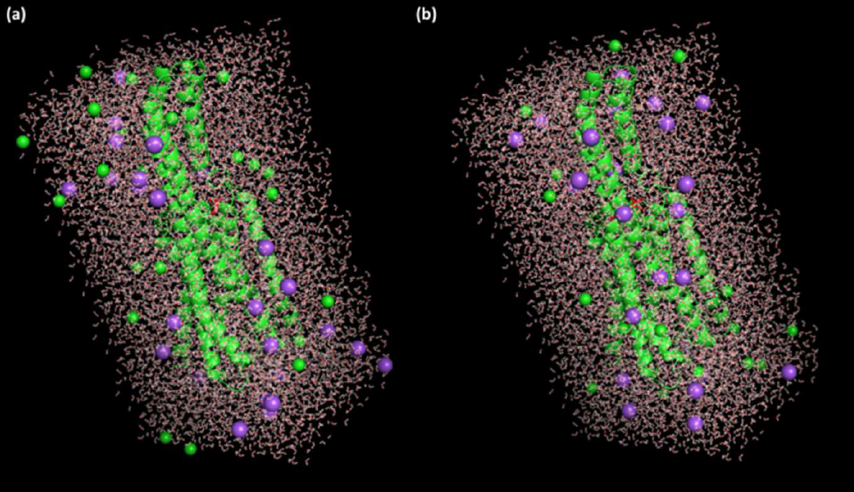
Figure 1. Receptor–ligand complex ( a ) (Bar)–Serotonin and ( b ) (Bar–CLA)–serotonin with 27 Na+ and 29 Cl − ions for neutralizing in a triclinic box solvated with water molecules. GROMACS analytic techniques were used for trajectory analysis [38]. The root-mean- square deviation (RMSD) was calculated using gmxrms instruments. Hydrogen bonding